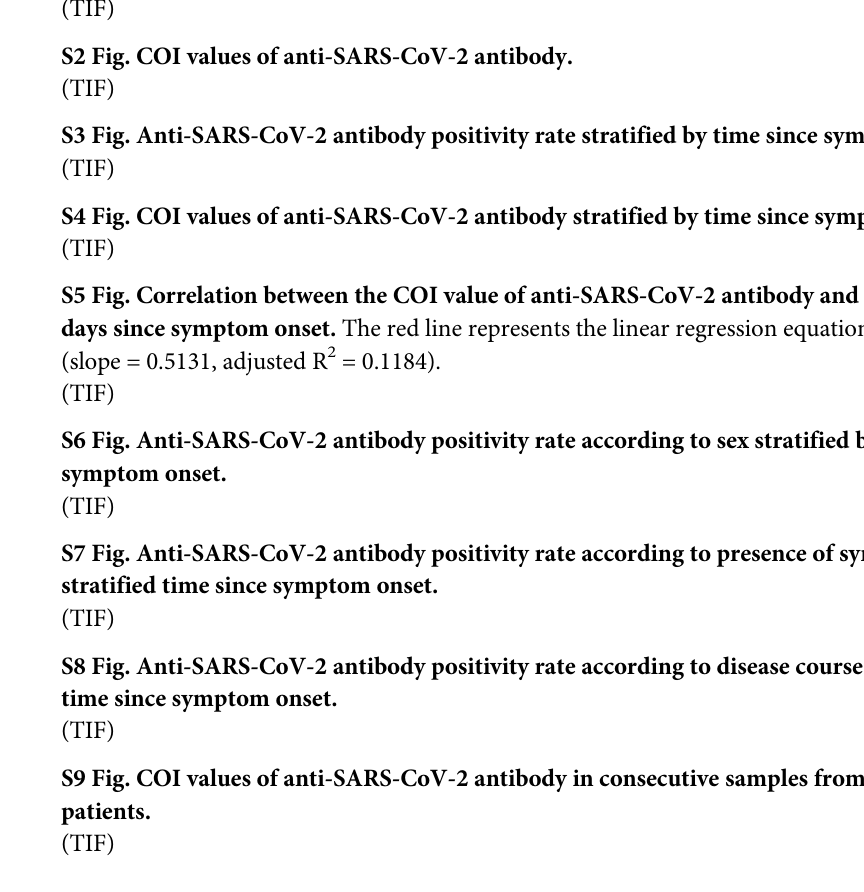
S1 Fig. Anti-SARS-CoV-2 antibody positivity rates of the institutions. S2 Fig. COI values of anti-SARS-CoV-2 antibody. S3 Fig. Anti-SARS-CoV-2 antibody positivity rate stratified by time since symptom onset. S4 Fig. COI values of anti-SARS-CoV-2 antibody stratified by time since symptom onset. S5 Fig. Correlation between the COI value of anti-SARS-CoV-2 antibody and number of days since symptom onset. The red line represents the linear regression equation (slope = 0.5131, adjusted R 2 = 0.1184). S6 Fig. Anti-SARS-CoV-2 antibody positivity rate according to sex stratified by time since symptom onset. S7 Fig. Anti-SARS-CoV-2 antibody positivity rate according to presence of symptoms stratified time since symptom onset. S8 Fig. Anti-SARS-CoV-2 antibody positivity rate according to disease course stratified time since symptom onset. S9 Fig. COI values of anti-SARS-CoV-2 antibody in consecutive samples from 119